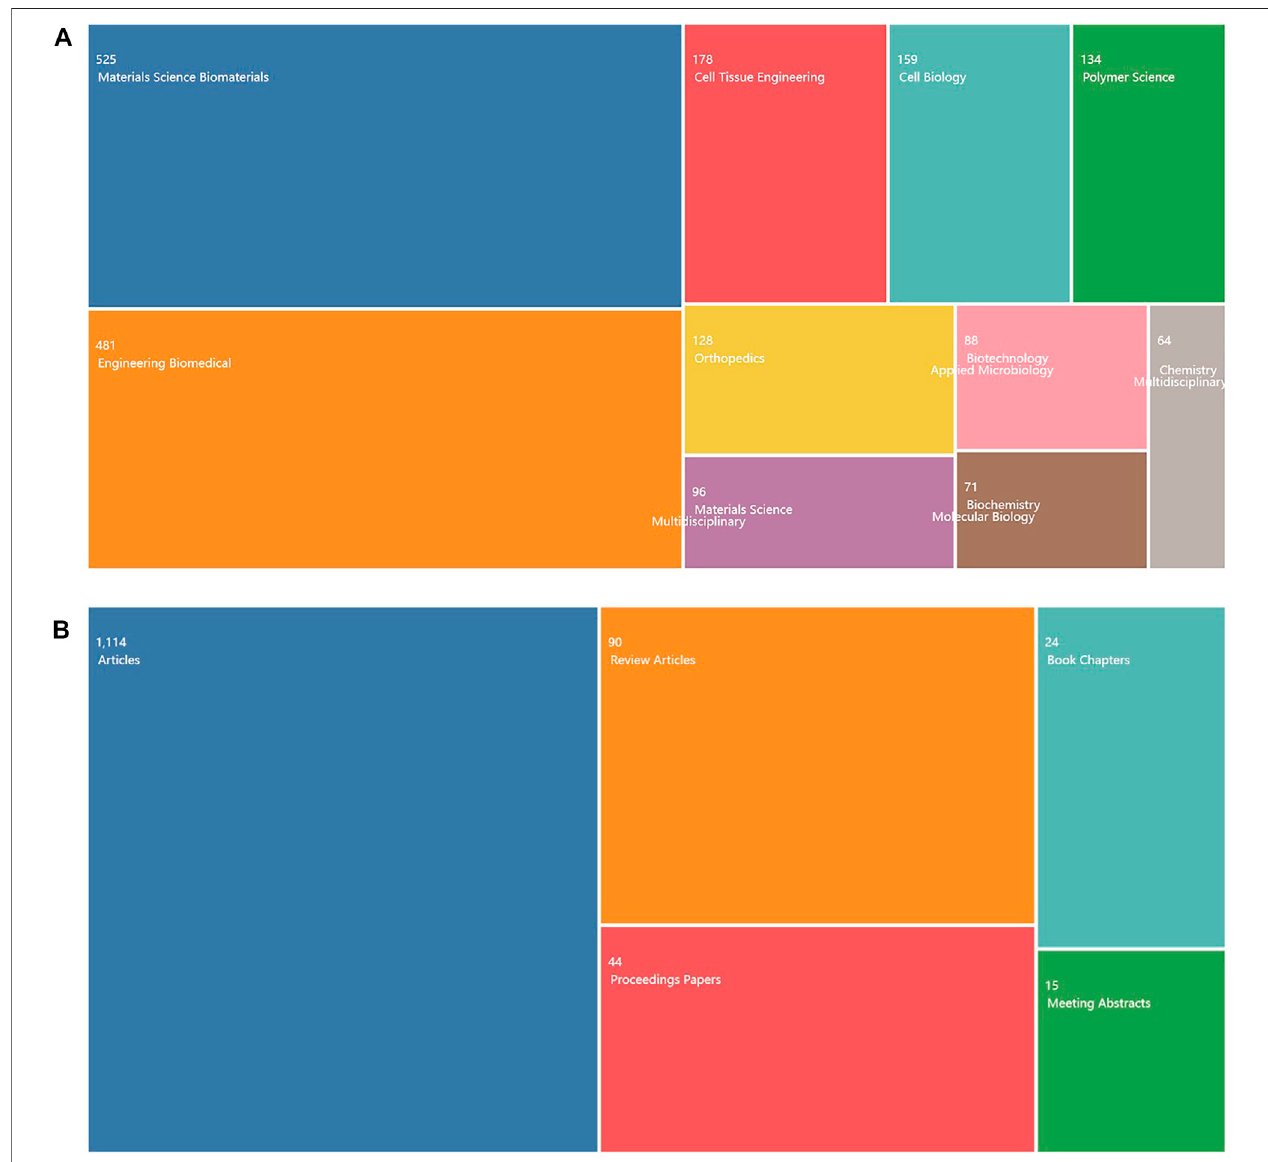
Figure 4 | Analysis of study category and article type related to research on hydrogels in cartilage repair. (A) Study categories of research on hydrogels in cartilage repair. (B) Article types of research on hydrogels in cartilage repair.